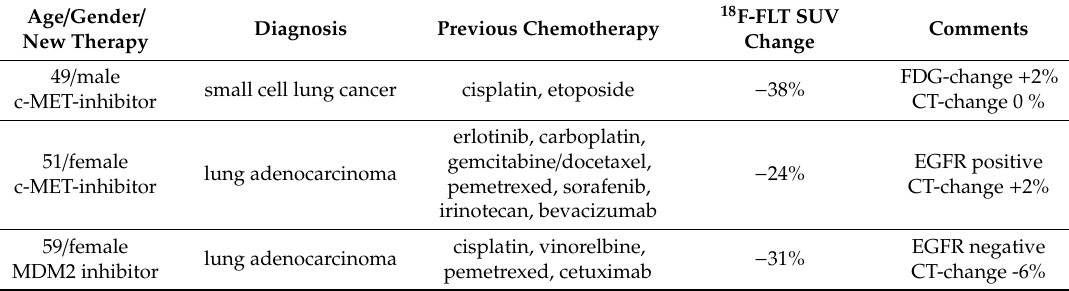
Table 1. Summary of the study. Patient characteristics (age, gender, diagnosis), new therapy, previous therapies, and the scan changes in the current study (FLT-PET / CT, FDG-PET / CT and